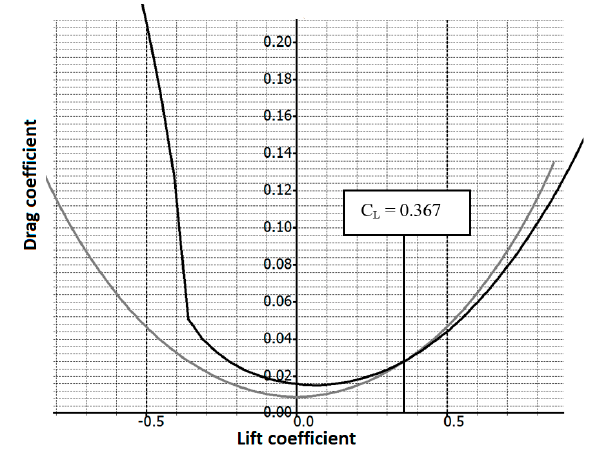
Figure 2. Drag coe ffi cient variation with the lift coe ffi cient for NACA0012 (grey) and NACA4412 Figure 2. Drag coefficient variation with the lift coefficient for NACA0012 (grey) and NACA4412 (black). For Cl = 0.367, angle of attack of NACA0012 = 7.8 ◦ and angle of attack of NACA4412 = 2.97 ◦ (black). For Cl = 0.367, angle of attack of NACA0012 = 7.8° and angle of attack of NACA4412 = 2.97°.